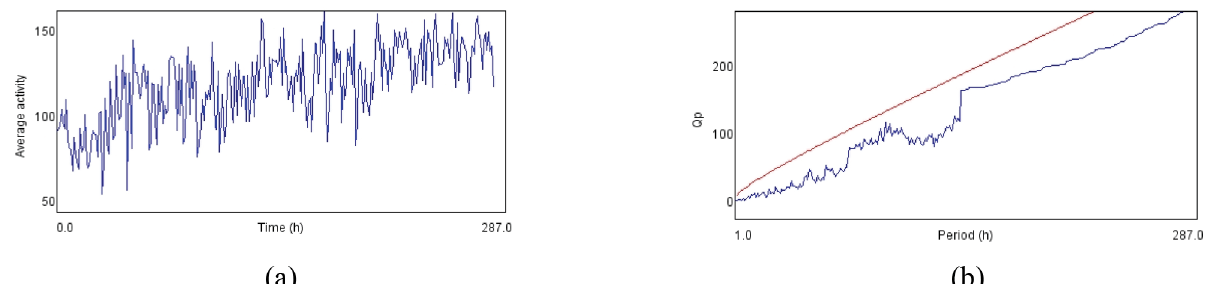
FIGURE 13S - (a) and (b) shows the average activity pattern and chi-square periodogram respectively for PD flies exposed to dopamine (10 -3